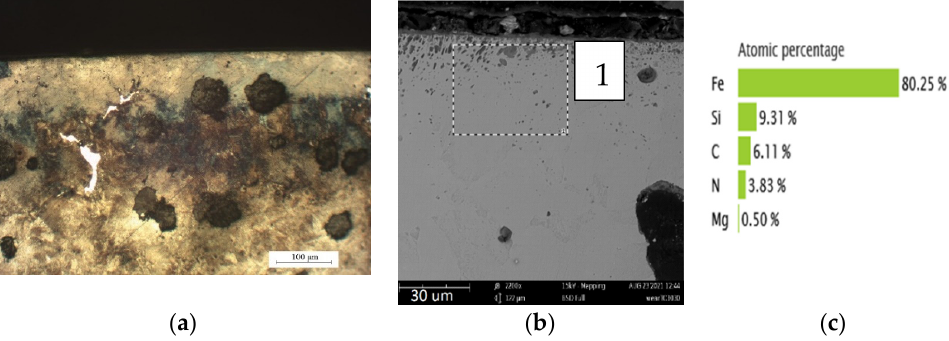
Figure 10. Nitrided layer of spheroidal graphite iron, layer defect: ( a ) microstructure of the zone with reduced hardness and depth (hardness 397–454 HV5, depth 0.23 mm); ( b ) SEM image, measured area (1); ( c ) histogram of the elemental composition of area 1.